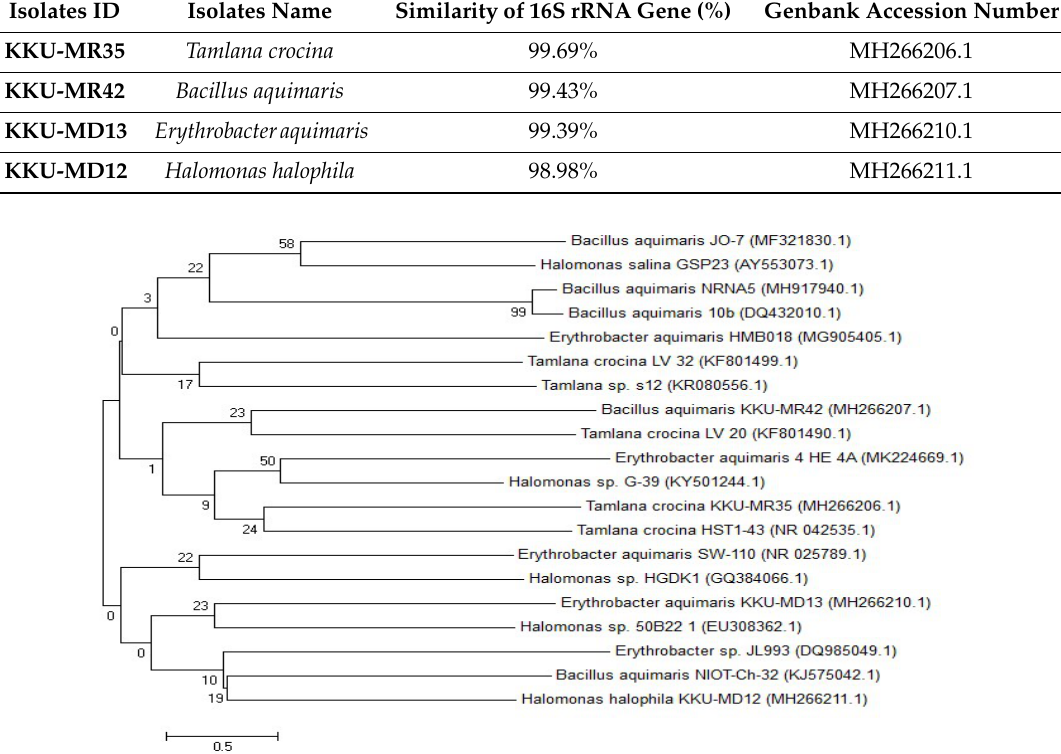
Figure 2. Phylogenetic tree based on 16S rRNA nucleotide sequences of the bacterial isolates Tamlana crocina , Bacillus aquimaris , Erythrobacter aquimaris , and Halomonas halophila , with other sequences of published strains generated by the neighbor-joining method using MEGA 5.0 software. The scale bar corresponds to a 0.05 nucleotide substitution per sequence position. The numbers at the nodes indicate the levels of bootstrap support (%) based on 1000 resampled data sets. The number in parentheses represents the accession number in GenBank.